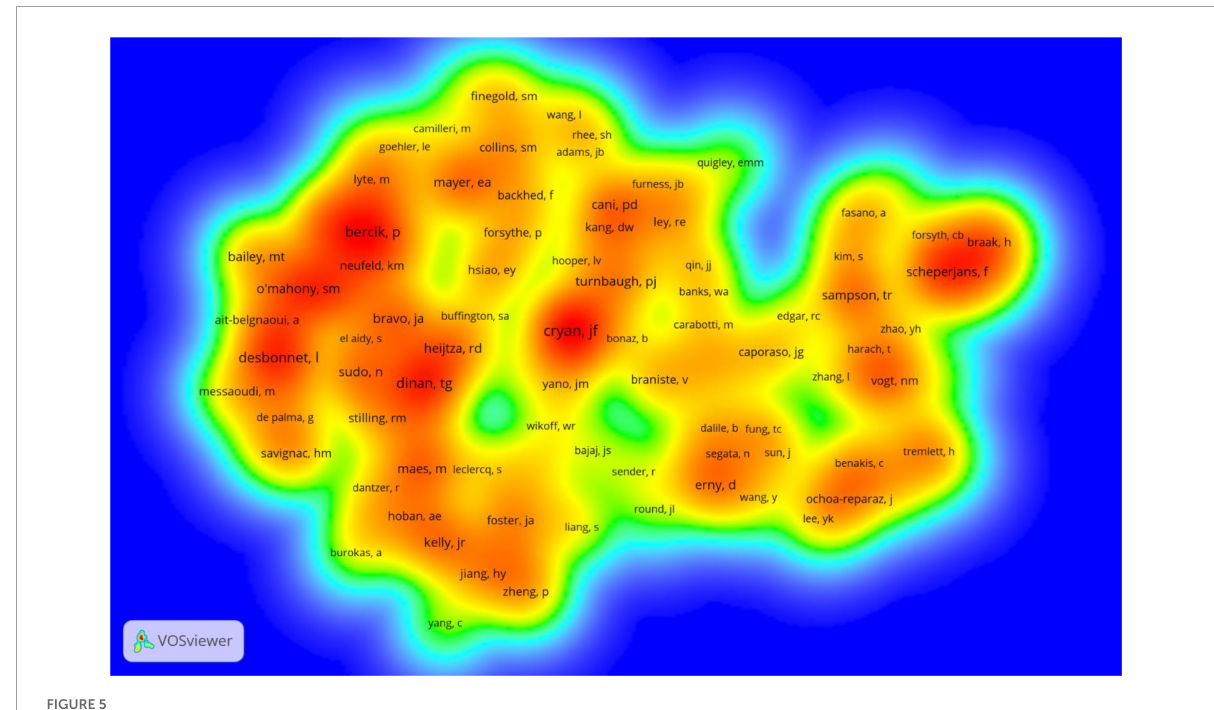
FIGURE5 The density map of co-cited authors on gastrointestinal microbiome and neuroscience research ( ≥ 100).